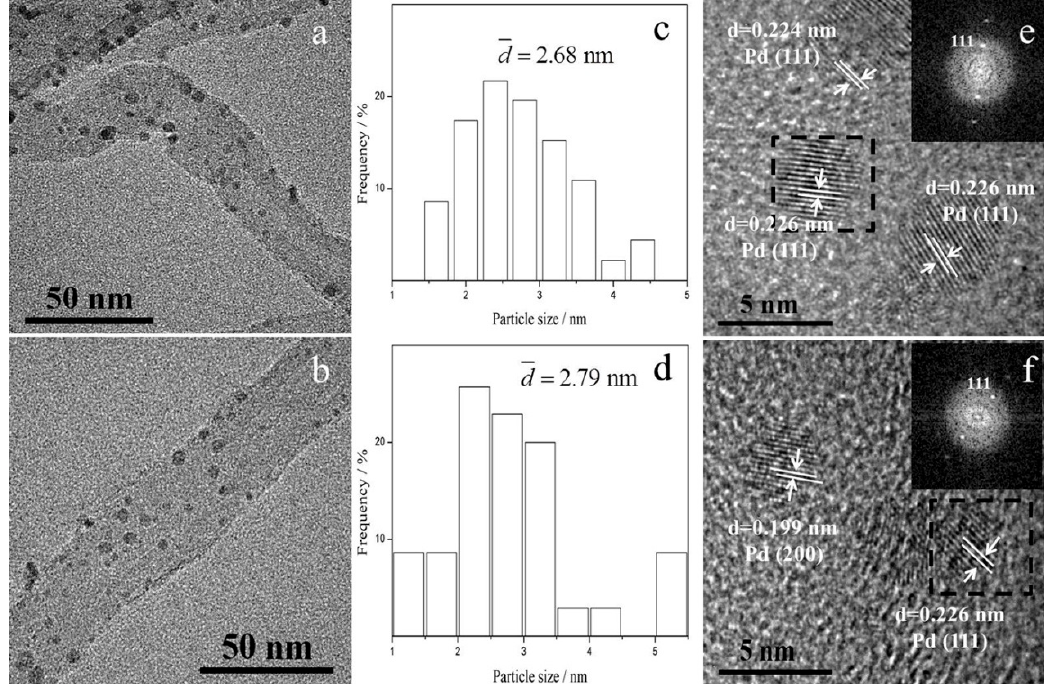
Figure 2. TEM ( a , b ) images and HRTEM ( e , f ) images of the fresh and used Pd/CNT-Ni foam micro reactors, respectively. ( c , d ) The corresponding particle size distribution of (a,b). The insets in (e,f) are the fast Fourier transform (FFT) patterns corresponding to the labeled